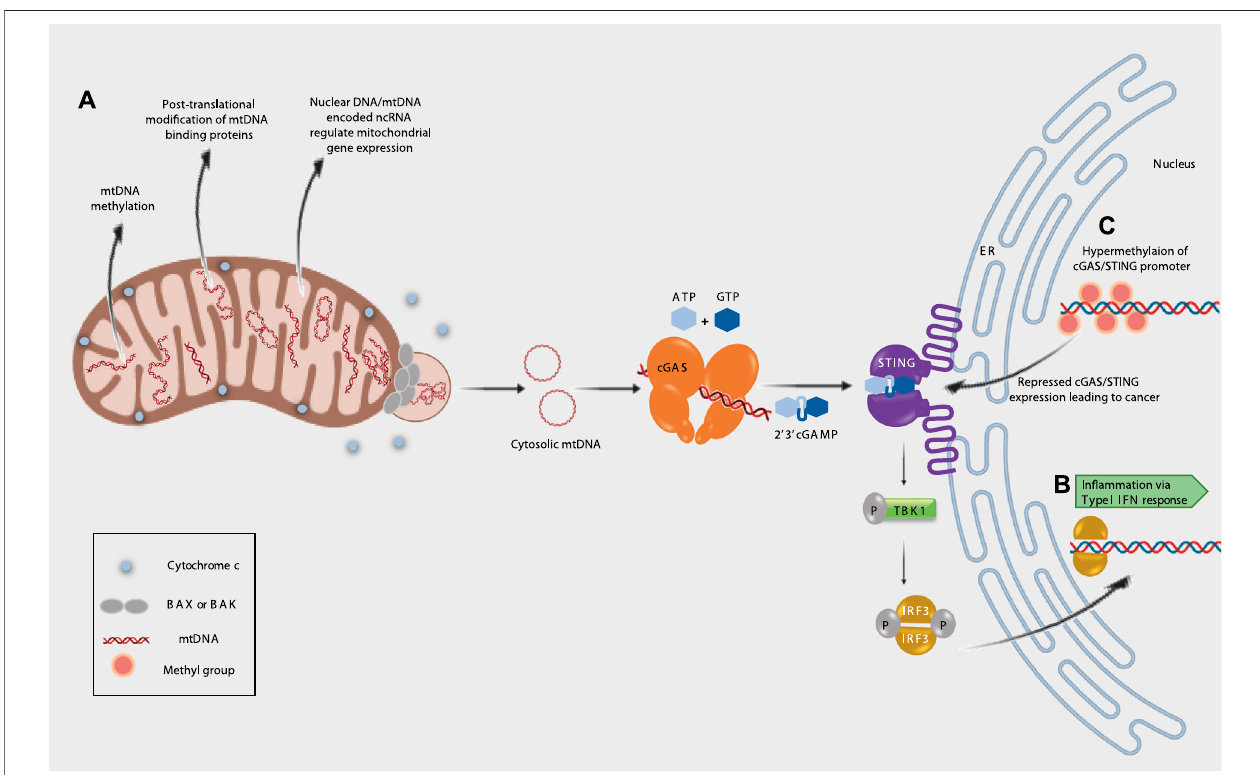
FIGURE 1 | Implications of mitochondrial epigenetics on in fl ammation, cancer and aging. (A) . Three major pathways regulating mitochondrial epigenetics. (B) . Extrusion ofmtDNA into thecytosol induces in fl ammation(Type IIFN response) via activated cGAS/STINGpathway. (C) . Epigenetic silencing ofcGAS/STINGpromoter region correlates with cancer